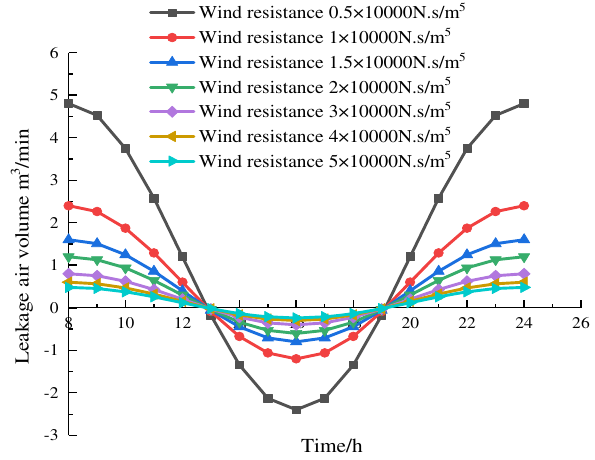
Fig. 3 Real time of air leakage under different wind resistances of single cosine